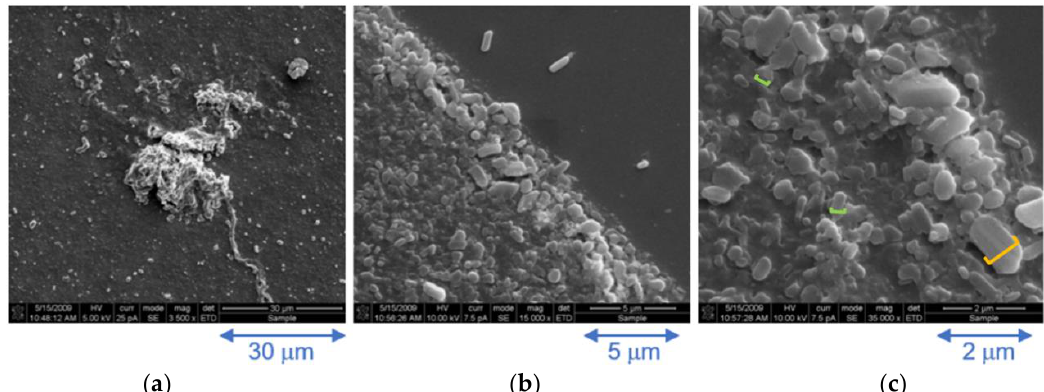
Figure 5. Cryo-SEM images of a 0.03 mM aqueous solution of complex 3 at increasing magnification; ( a ) ×3500, ( b ) ×15,000 and ( c ) ×35,000.